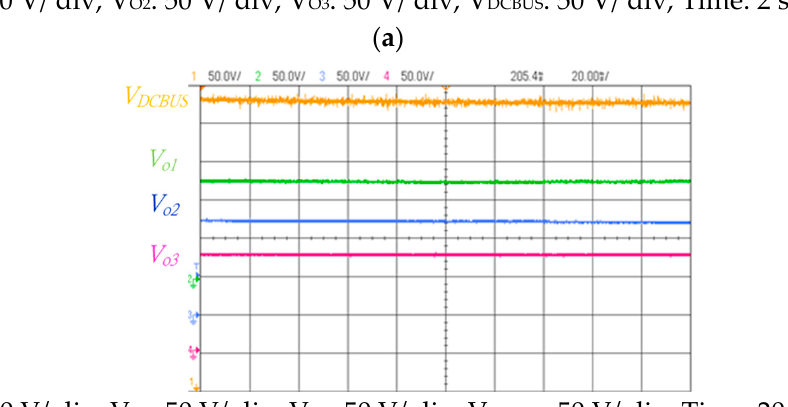
Figure 15. The output voltages of three modules when the system is operated in normal mode ( a ) transient ( b ) steady state.